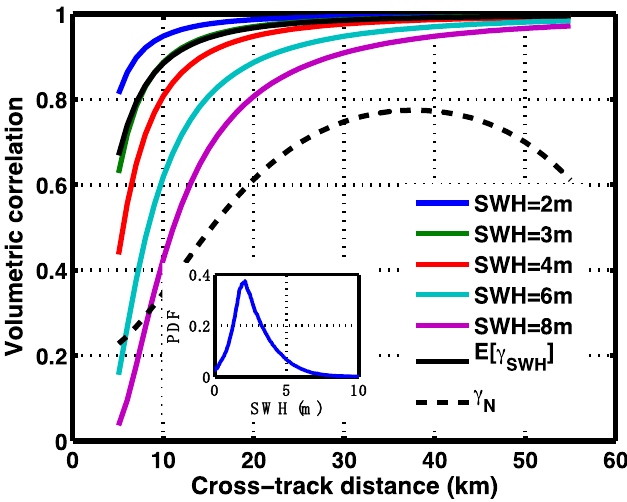
Figure 1. Decorrelation due to volume scattering from a Gaussian distributed layer as a function of cross track distance for different values of significant wave height (SWH). The black solid curve is the expected volume scatter correlation averaged over global SWH conditions modeled using one year of WAVEWATCH-III data (insert contains the SWH probability density function). The black dashed curve illustrates the decorrelation due to noise only for comparison. The total decorrelation is the product of these two decorrelation factors, and also the smaller geometric/angular decorrelation